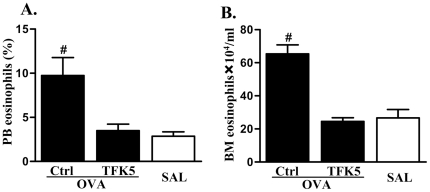
The effects of neutralization of IL-5 on eosinophil levels in peripheral blood and bone marrow in the absence of STAT6.The increased (A) percentages of eosinophils in peripheral blood and (B) numbers of eosinophils in bone marrow in response to OVA/OVA treatment were completely abolished by neutralization of IL-5 with anti-IL-5 antibody in STAT6-deficient mice. #P<0.05 compared to other groups.